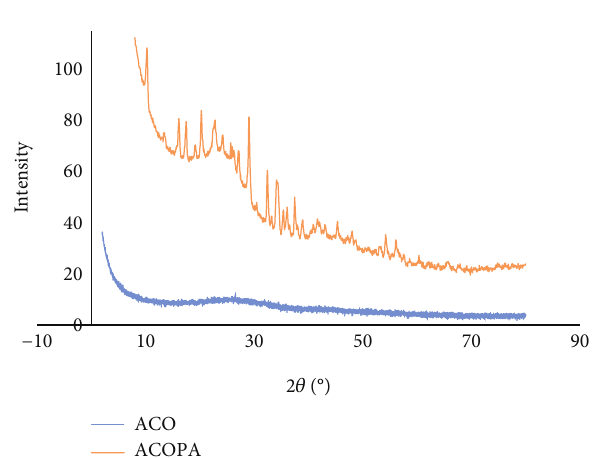
Figure 2: SEM analysis of (a) ACO and (b) ACOPA.